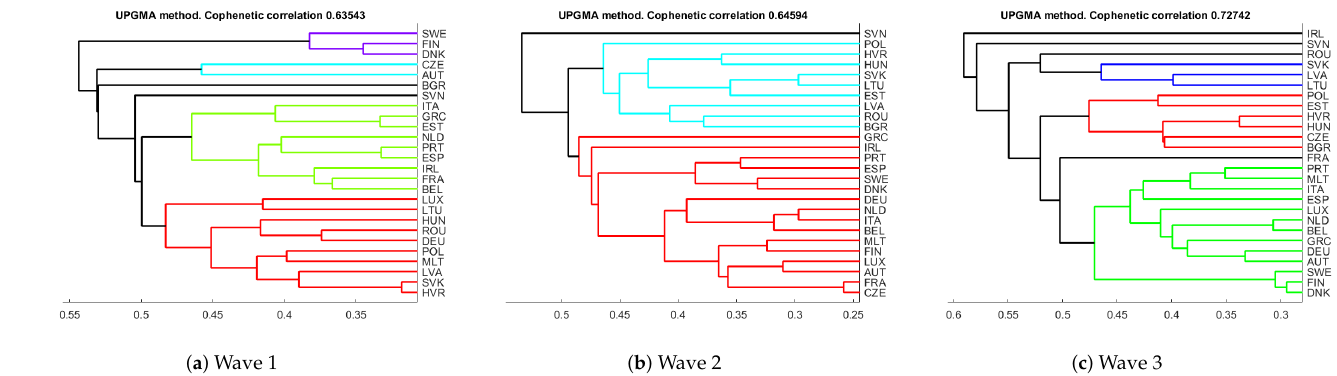
Figure A2. Visualization step: Hierarchical clustering for waves 1 to 3. Gower’s